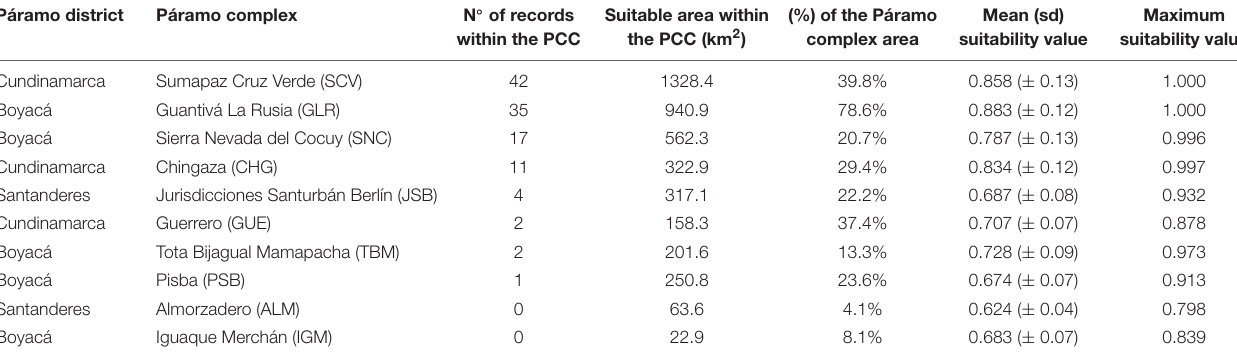
TABLE 1 | Number of occurrences of P. quadrijuga , and resulting suitable areas for each Páramo Complex of Colombia (PCC; Sarmiento et al., 2013). Páramo district Páramo complex N ◦ of records